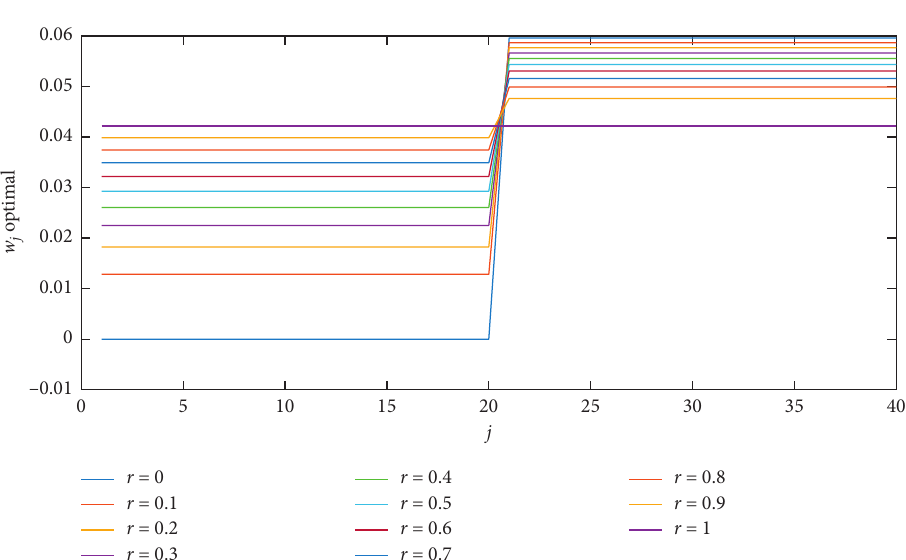
Figure 5: The convergence of the neural network weights for each r -cut for Example